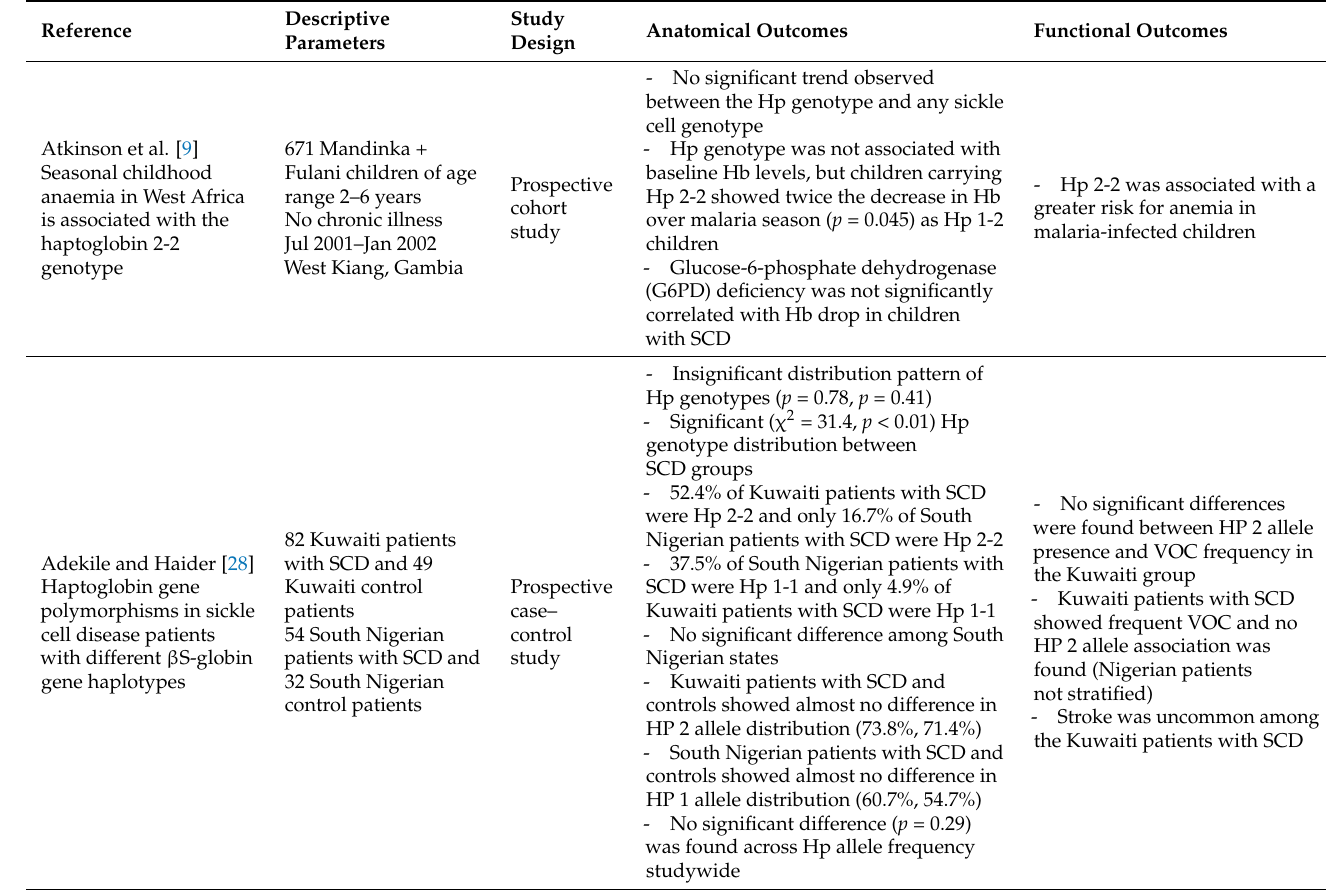
Table 1. Summary of clinical studies relating SCD, Hp genotype, and stroke